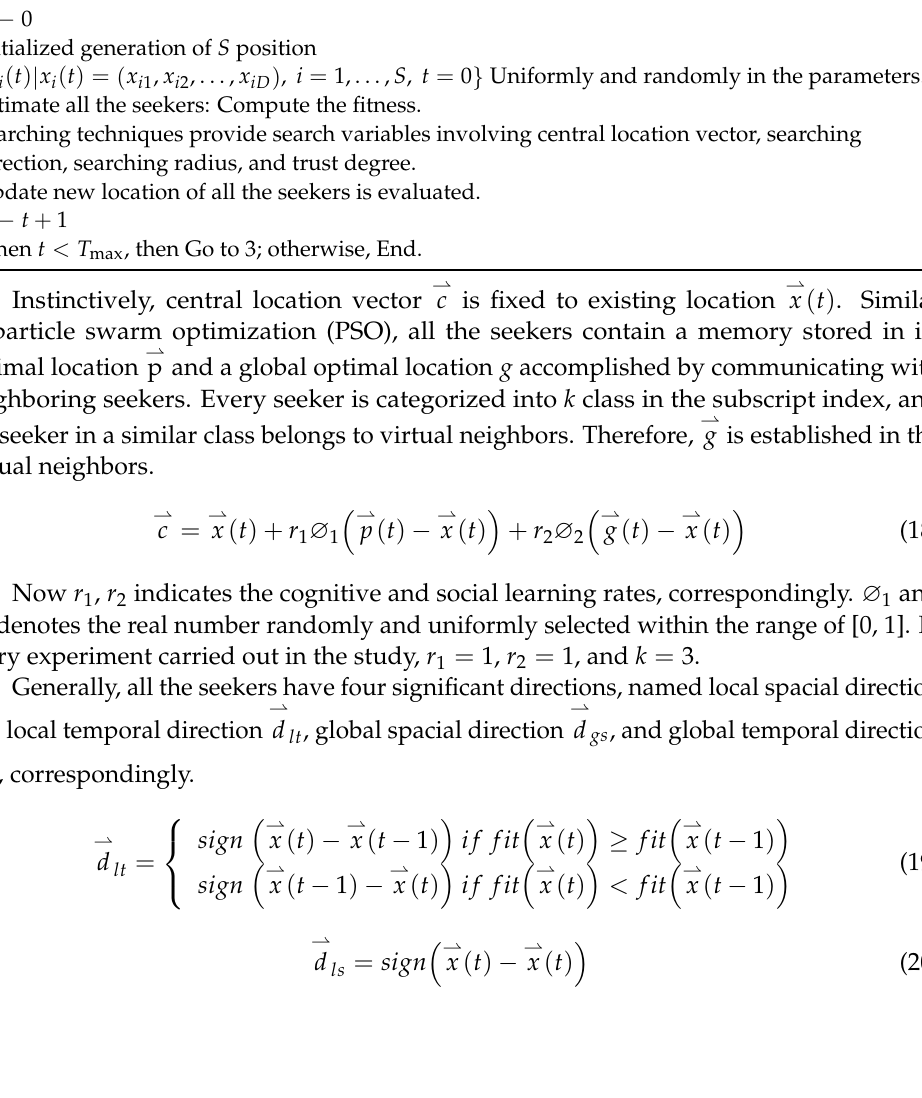
Algorithm 1: Pseudocode of